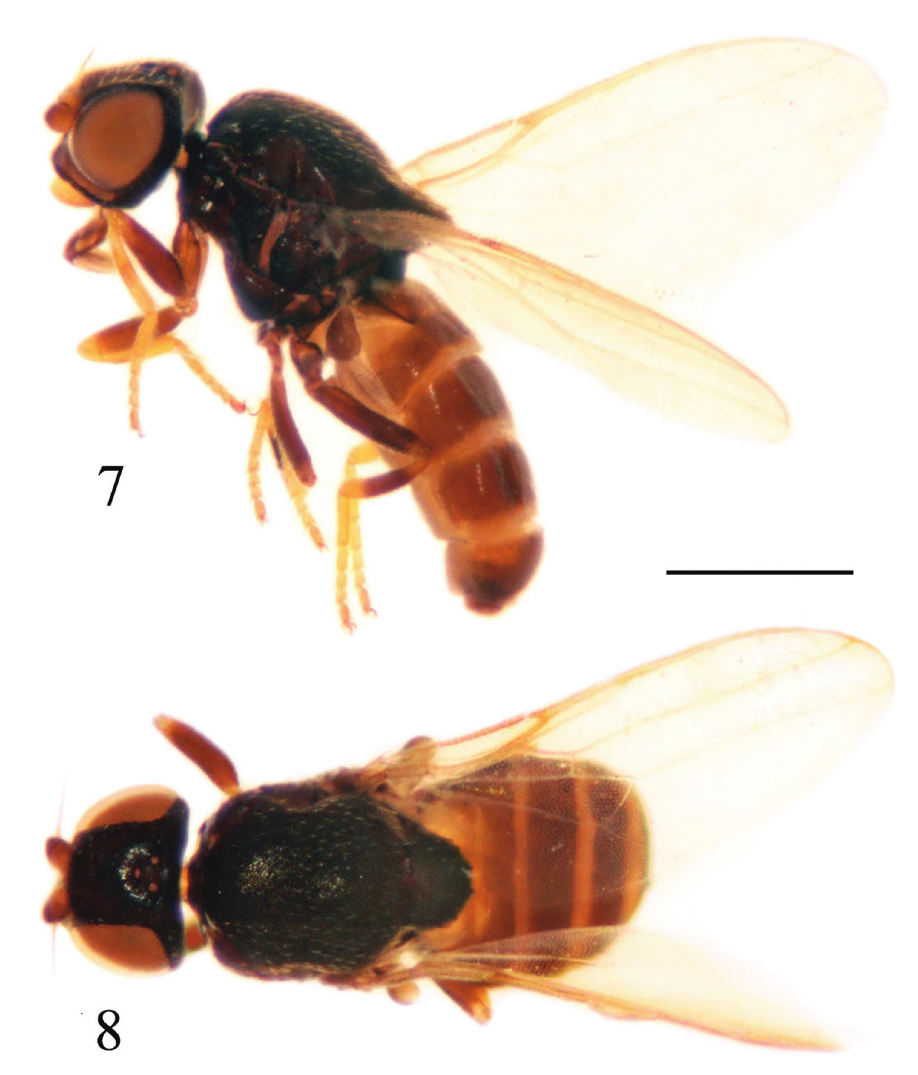
Figures 7–8. Siphunculina scalpriformis sp. n., holotype. habitus 7 lateral view 8 dorsal view. Scale bar 0.05